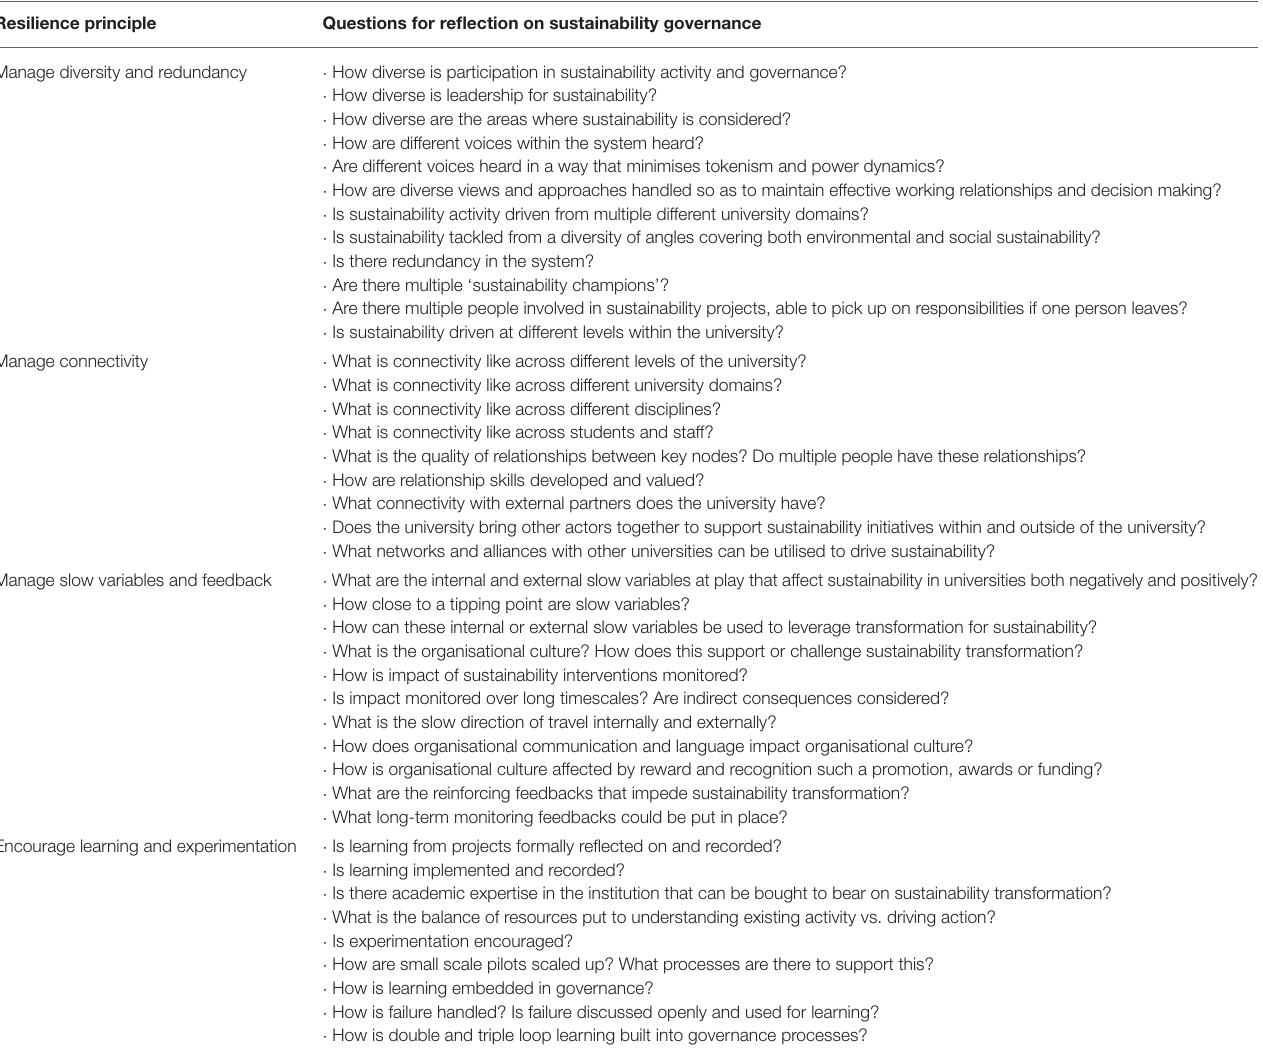
TABLE 2 | Questions for reflection on sustainability governance based on the four resilience